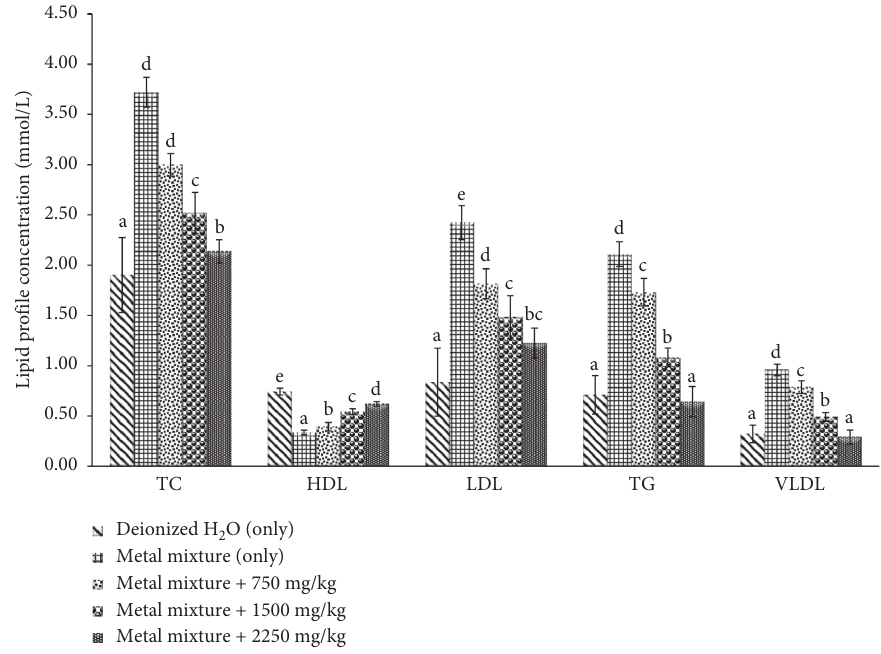
Figure 2: Effect of Costus afer on lipid profile parameters of male albino rats treated with metal mixture.